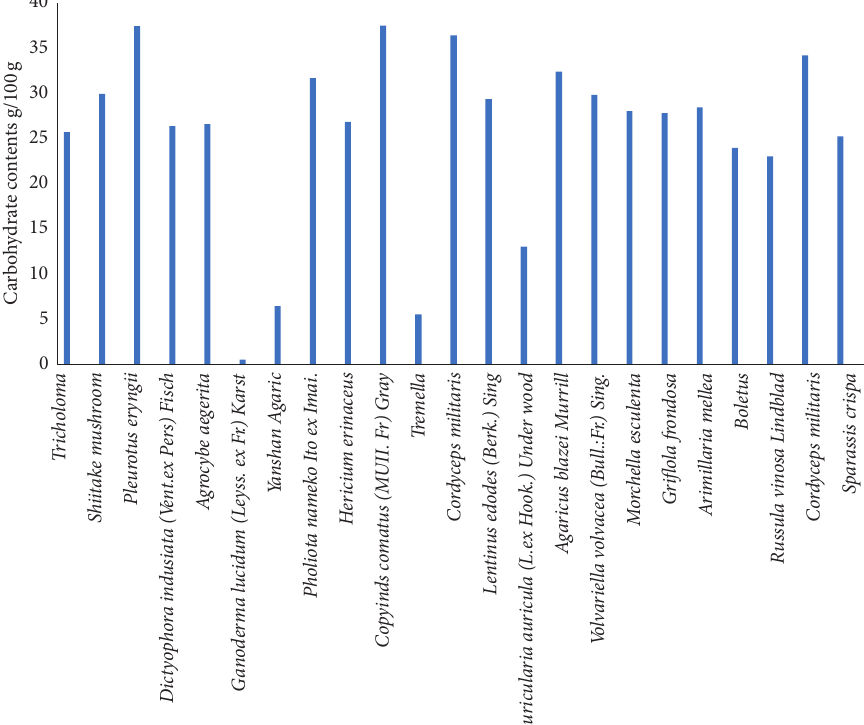
Figure 7: Carbohydrate contents of 23 kinds of edible